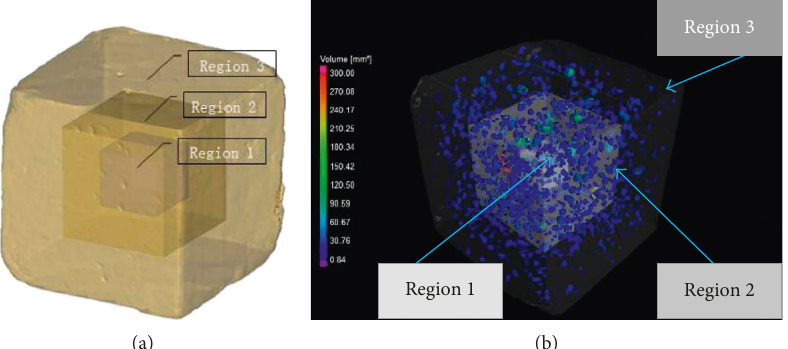
Figure 20: 3D view of pore’s structure in different divided regions with color-coded pores according to size. (a) Pore divided region schemes and (b) 3D reconstruction of pore’s structure in different divided regions (42 days of sulfate